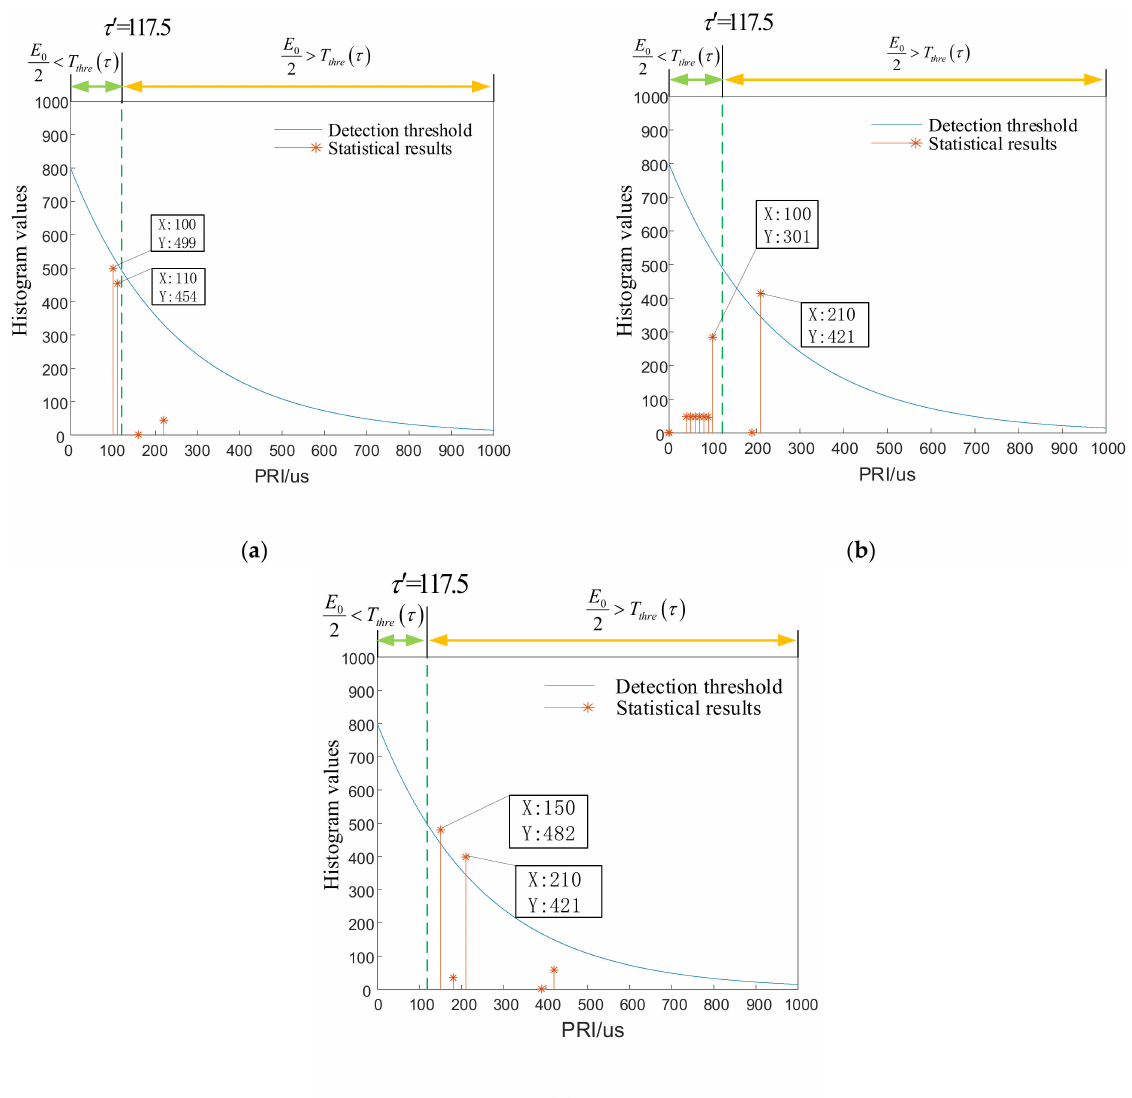
Figure 4. Histogram of first-order TOA difference in simulation case 2. ( a ) The PRI values of both signals smaller than the sorting failure critical condition; ( b ) a signal with a PRI value larger than the sorting failure critical condition; ( c ) the PRI values of both signals larger than the sorting failure critical